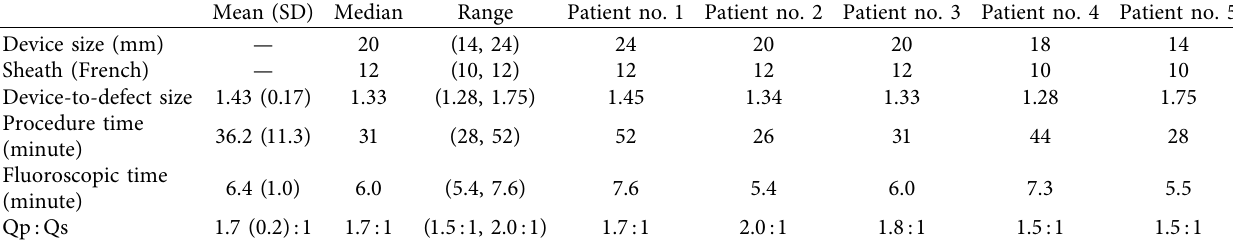
Table 2: Procedure